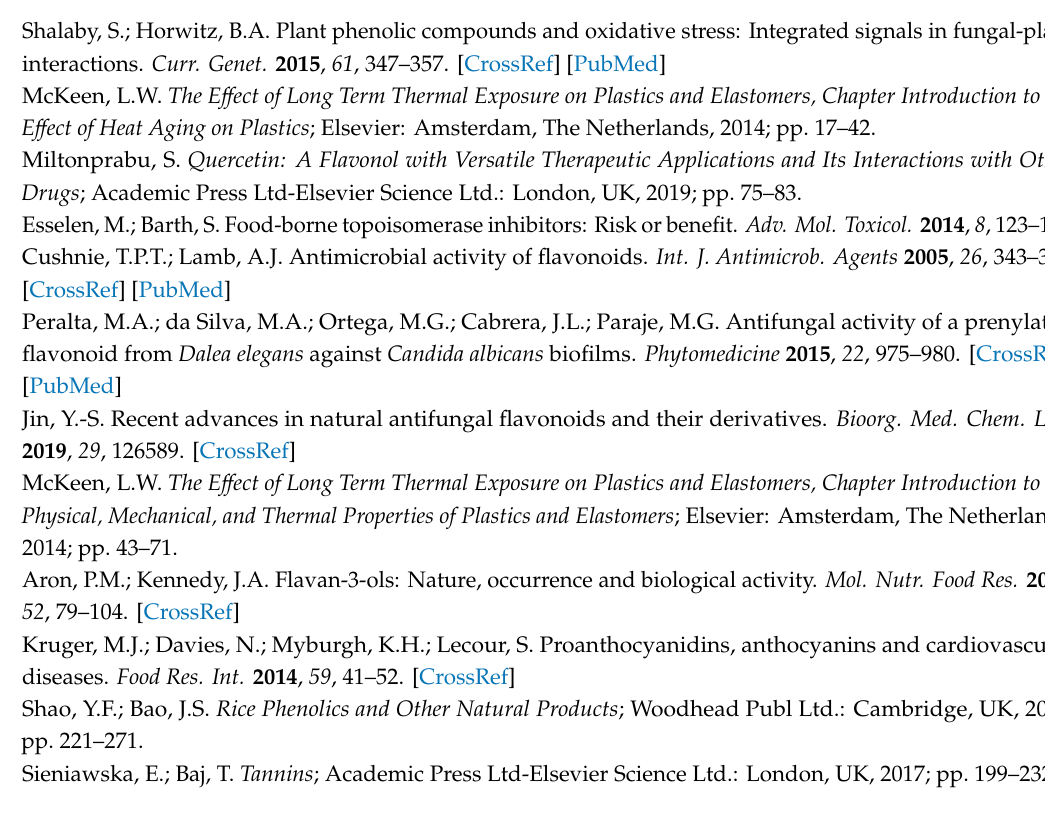
Table S1: Probabilities for post-hoc Dunnett’s tests (2-sided), Table S1: Correlation